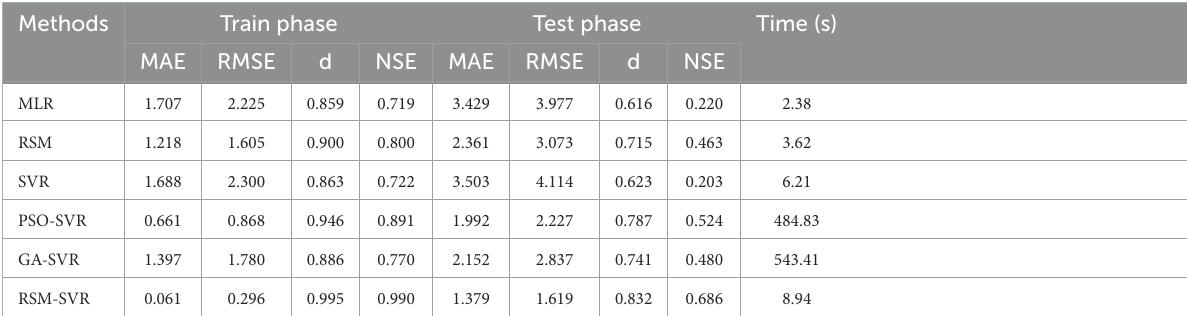
TABLE 3 Comparative error and agreement